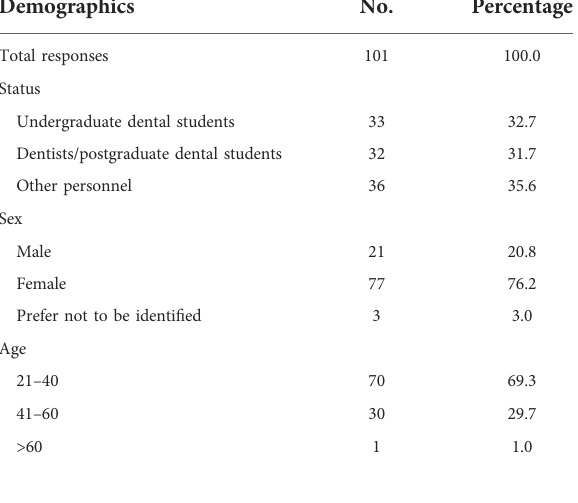
TABLE 3 Sociodemographic characteristics of self-administered questionnaire responders.